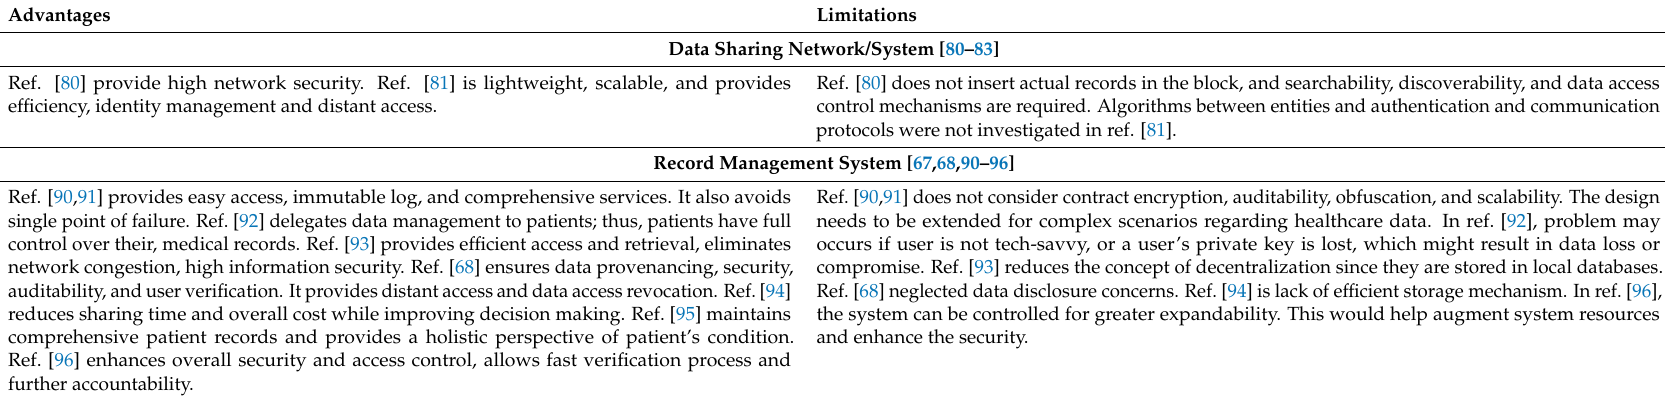
Table 2. Advantages and limitations of related